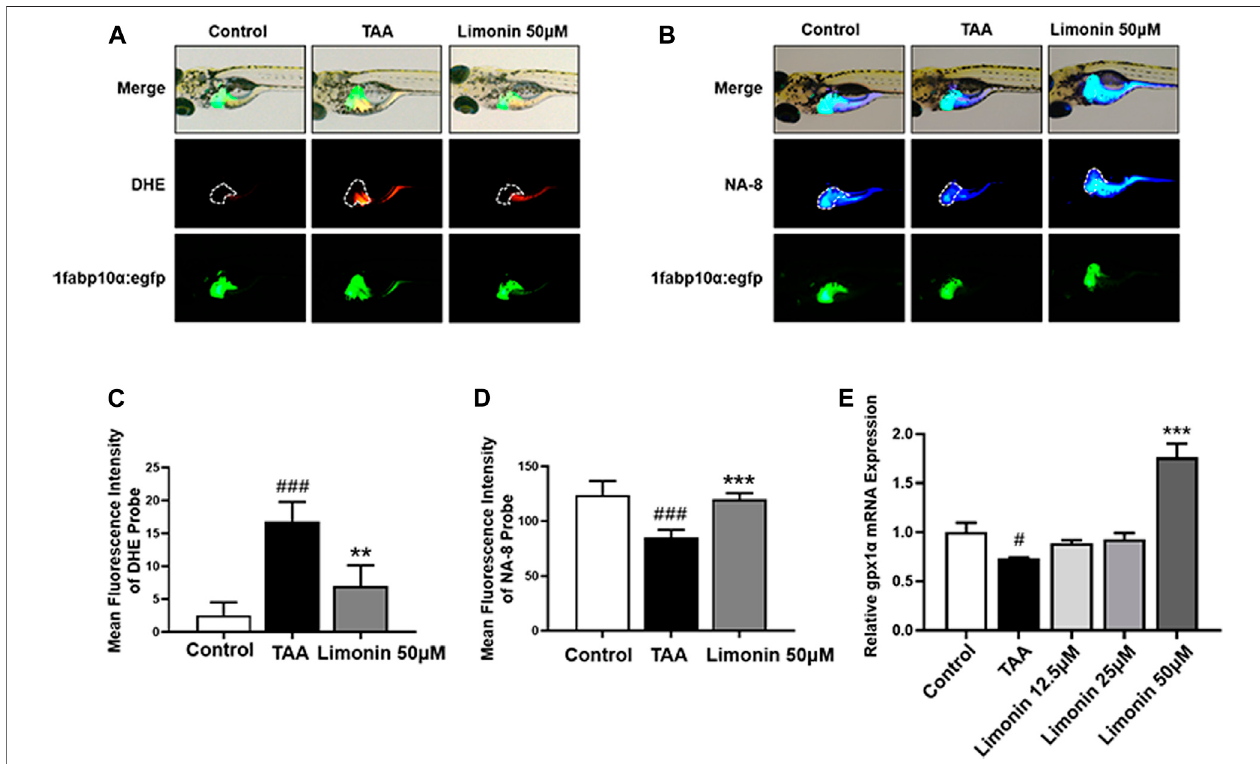
FIGURE 7 | Limonin protected zebra fi sh larvae against oxidative stress. (A) Fluorescence micrographs of DHE. Figures are magni fi ed as 50 × . (B) Fluorescence micrographs of NA-8. Figures are magni fi ed as × 50 (C) ROS quanti fi cation according to the mean intensity of red fl uorescence. (D) GSH quanti fi cation according to the meanintensity ofblue fl uorescence. (E) Real-time PCRanalysisofgpx1a mRNAlevelsin zebra fi shlarvae.ThemRNA levels werenormalized to β -actin mRNAlevelsand presentedasfoldchangecompared withthecontrolgroup. Dataareshown asthemean ± SD( n (cid:1) 4 – 6pergroup). # p < 0.05, ## p < 0.01,### p < 0.001vscontrol group; * p < 0.05, ** p < 0.01, *** p < 0.001 vs TAA